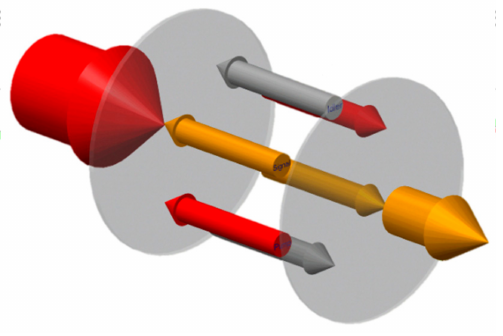
Figure 11. Schematic diagram illustrating the principle of the relaxation method when applied to analysis of cascade